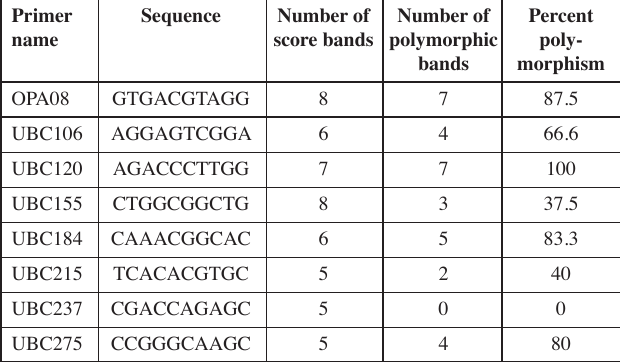
Fig. 2: thiosulphinates [i.e., allicin (2)], ajoenes [i.e., E -ajoene